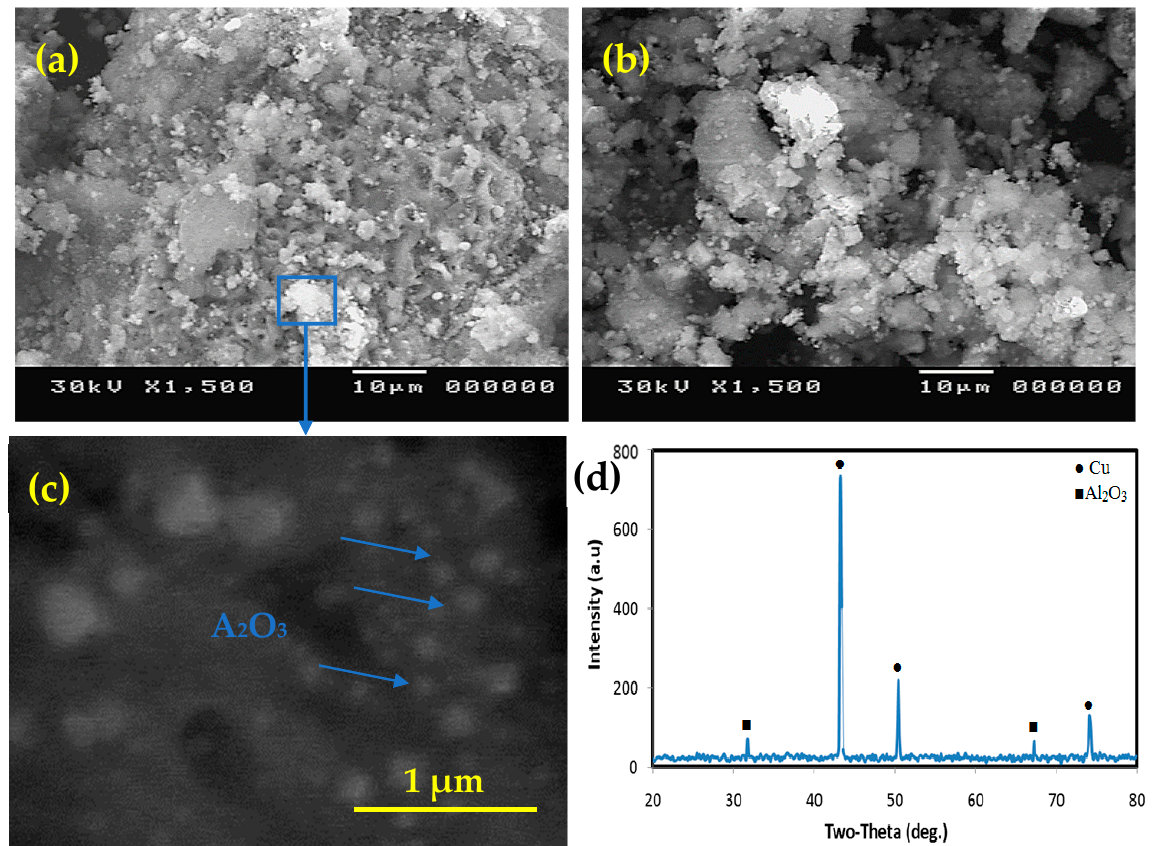
Figure 3. SEM micrograph of the nanocomposite powders; ( a ) Cu-2.5%Al 2 O 3 , ( b ) Cu-12.5%Al 2 O 3 , ( c ) enlarged image of the rectangular area marked in ( a , d ) XRD of Cu-12.5%Al 2 O 3 .